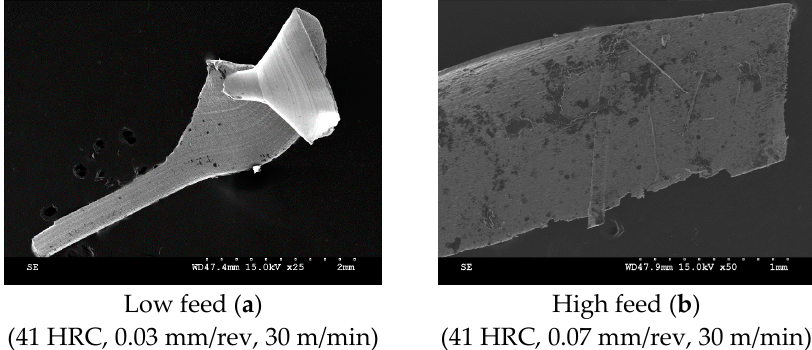
Figure 19. Cutting tool chips of 41 HRC Rene 65 samples at: ( a ) low feed, ( b ) high feed.